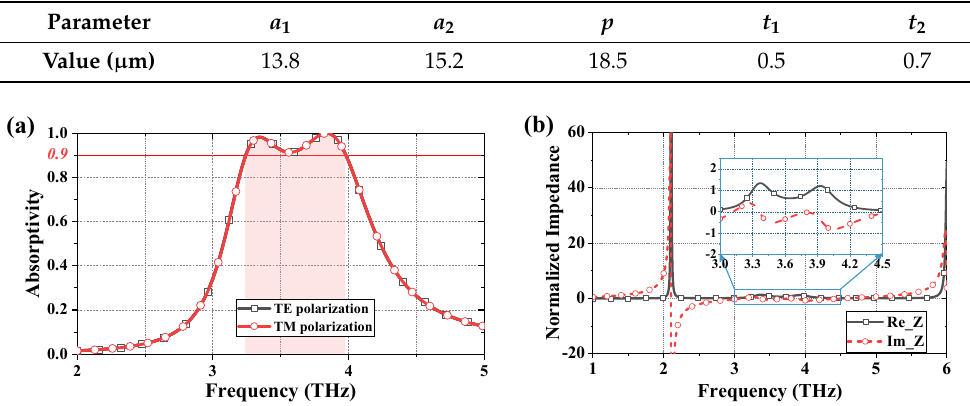
Table 2. The optimized parameters of metasurface absorber. Parameter